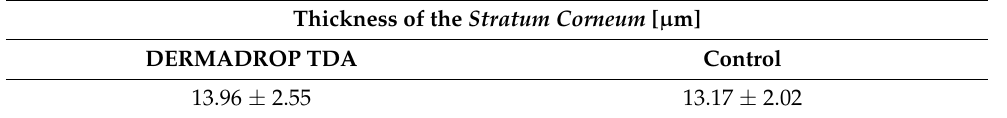
Figure 3. Histological section of porcine skin treated with 16 µ L Matrix TDA via the medical device DERMADROP TDA ( left ) and pipette ( right ). HE-stained, 10 µ m thin skin sections cut transversal to skin surface; bar represents 100 µ m. Table 4. Thickness of the stratum corneum of control samples in comparison to the medical device DERMADROP TDA treated samples after HE-staining; no statistical significance was observed (Mann–Whitney Test); n =